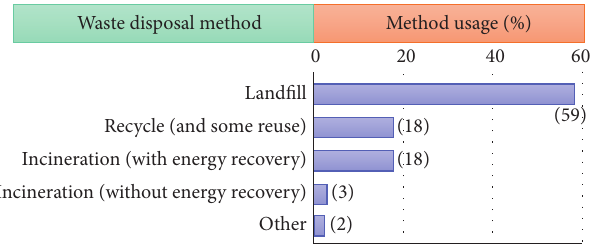
Figure 4: Scottish salmon farming waste disposal routes [131].